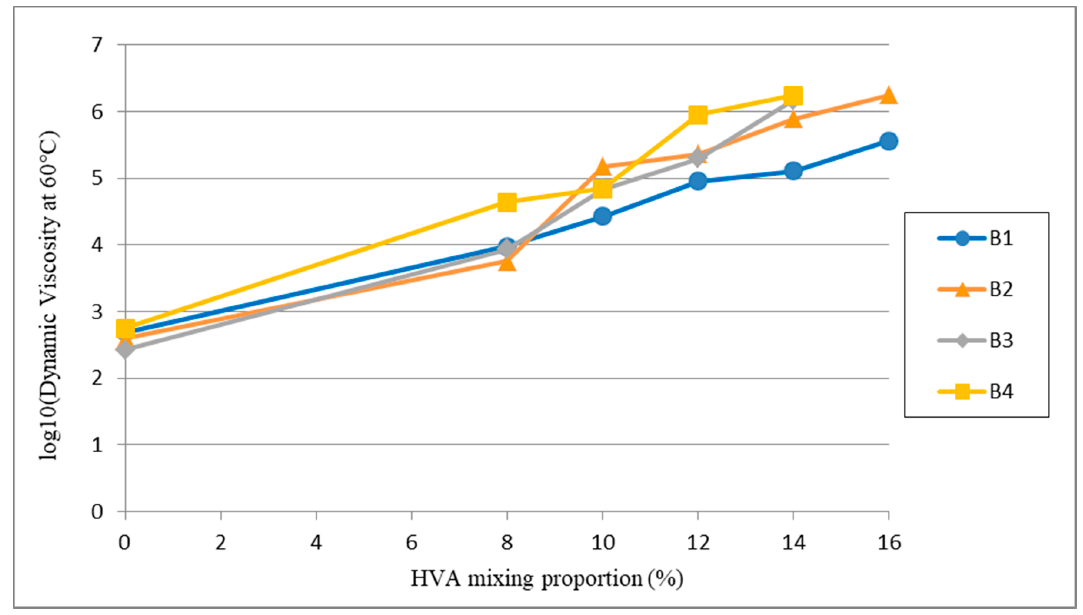
Figure 4. Dynamic viscosity at 60 °C of asphalt with different HVA mixing proportions.